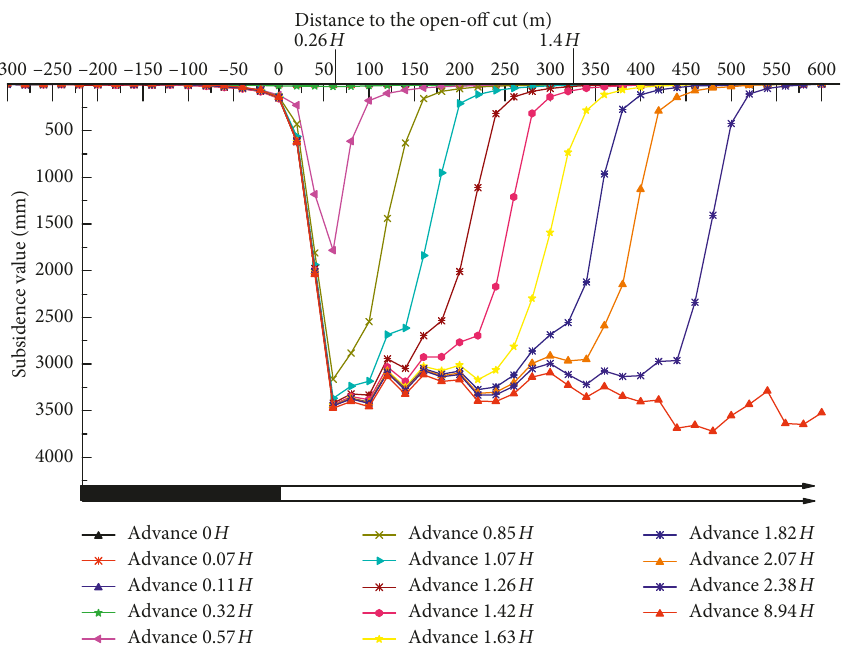
Figure 4: Dynamic subsidence curves of longitudinal